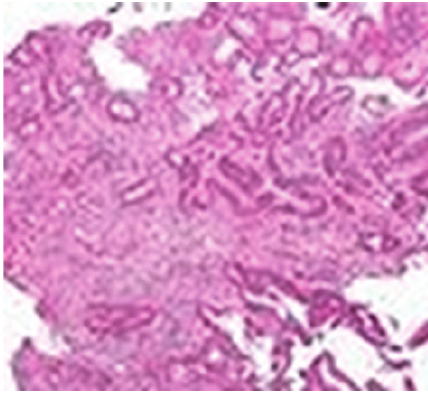
Figure 1: H&E of colon showing invasive adenocarcinoma.